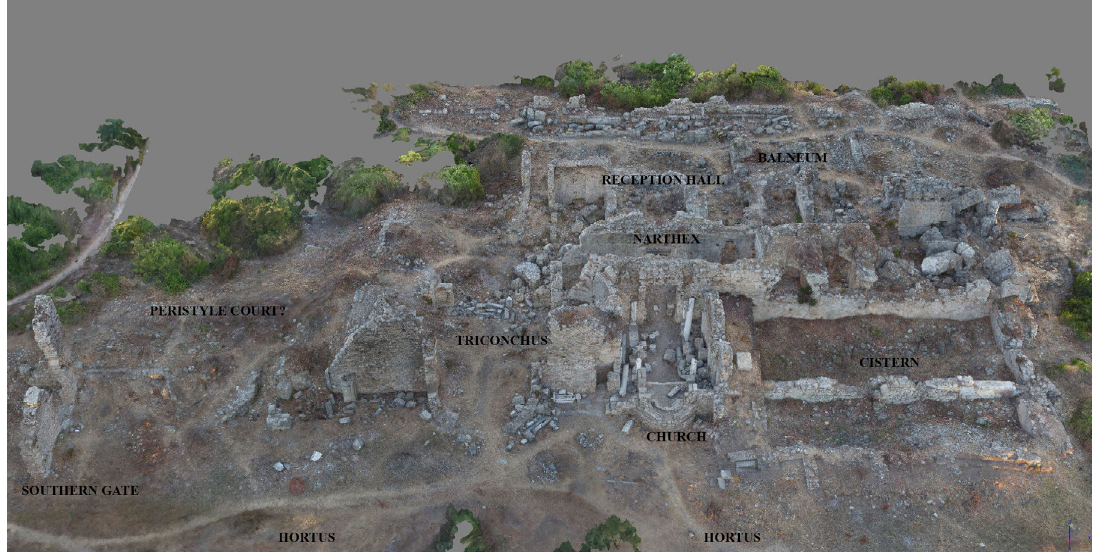
Figure 3. Episcopal residence, 3D model view to the west © ÖAW/IKAnt (M. Hernandez Cordero). Finally, south of the living quarters and the church, a huge triconchus (most probably the triclinium ) is preserved. The main room with its trifold apses in the east was accessible from an almost square vestibulum in the west . The door between the two rooms was constructed with Roman marble blocks and designed as a tribelon . Next to this building, another complex with several premises followed, one of them having an east-facing apse. As the research stands at present, an interpretation of this partly excavated building is not